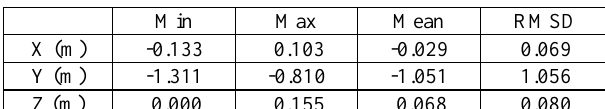
Table 3. The statistic values of difference of translations